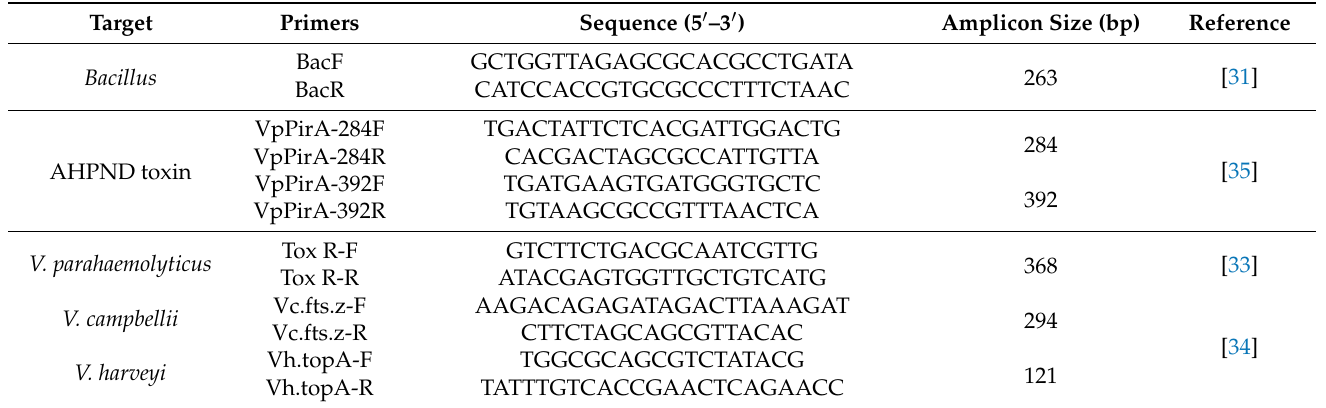
Table 1. Primers for Bacillus , AHPND toxin genes ( pir A and pir B), and Vibrio